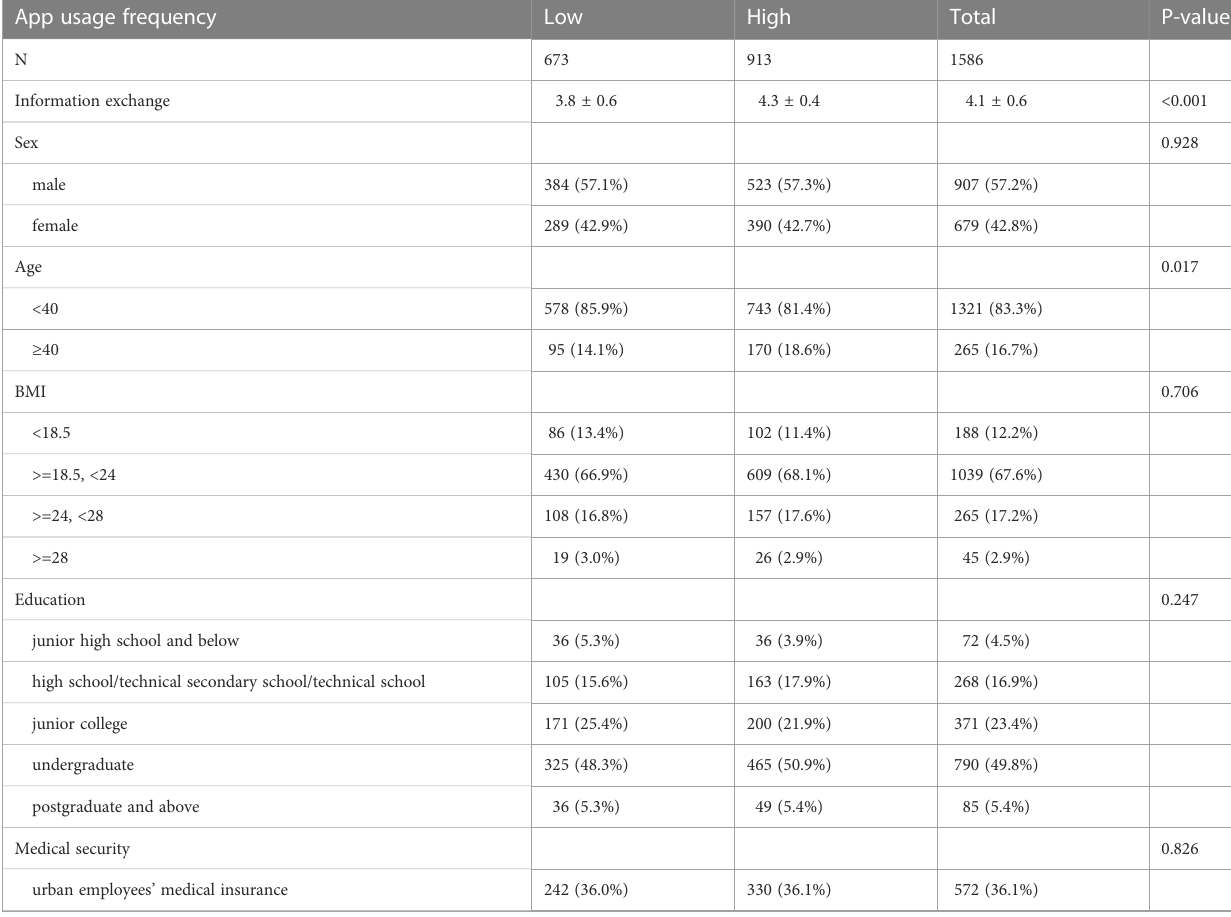
TABLE 1 Baseline characteristics of eligible participants, including their online app usage frequency classi fi